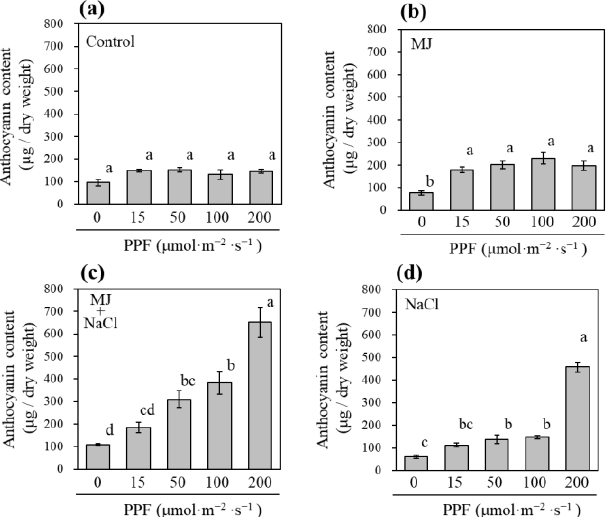
Figure 5. E ff ect of light intensity on the growth and anthocyanin accumulation in radish sprouts treated with MJ and salinity. Anthocyanin contents were measured after 0, 15, 50, 100, or 200 µ mol m − 2 s − 1 PPF light exposure (in a 16-h light / 8-h dark photoperiod) from 2 days after sowing (DAS) of the sprouts treated with water ( a ), 0.5 mM MJ ( b ), 200 mM NaCl ( c ), and the co-treatment with 0.5 mM MJ and 200 mM NaCl ( d ). Error bars represent ± SE ( n = 6). Di ff erent letters indicate significant di ff erences by Tukey’s multiple comparison test ( P < 0.05).